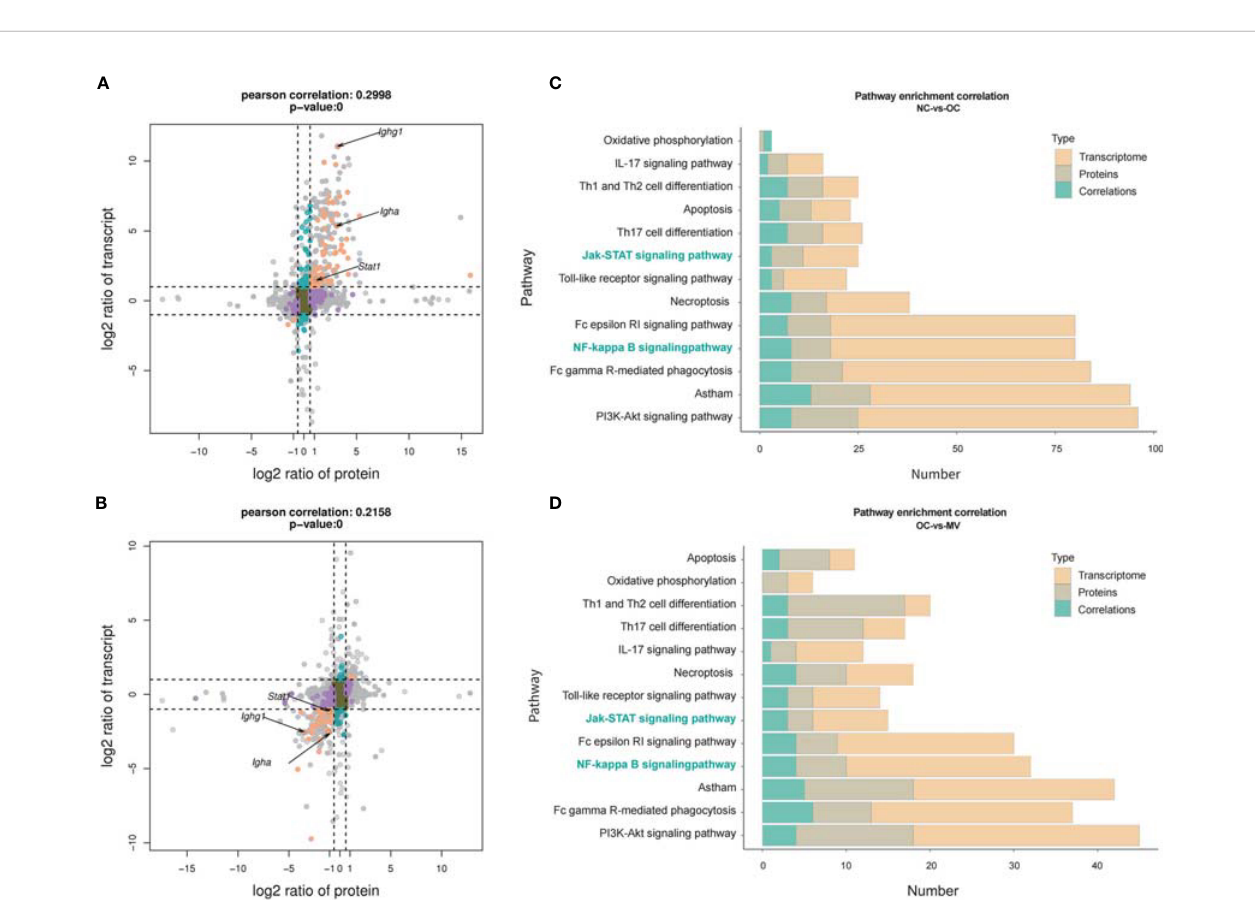
FIGURE 6 | Correlation between transcriptome and proteome. (A) Normal control group (NC) vs . ovalbumin control group (OC). (B) OC vs . the group treated with 50 mg/kg mogroside V (MV), nine-quadrant graph (considering the statistical signi fi cance, p ) [The abscissa is the fold change of the protein (take log2), the ordinate is the fold change of the transcriptome (take log2), and at the top of the fi gure is the Pearson correlation and statistical signi fi cance, p , associated with the transcriptome and the proteome. Each dot represents a gene/protein: the brown dots represent non-different proteins and genes, and the red dots represent the same or opposite trend of changes in genes and proteins, and the blue dots indicate the differential expression of genes but non-differential expression of proteins]. Histogram of the number of genes on the pathway overlapped by NC vs . OC (C) and OC vs . MV (D) [The number of differentially expressed mRNA (red), protein (gray), and associated genes (blue), respectively, is annotated on the